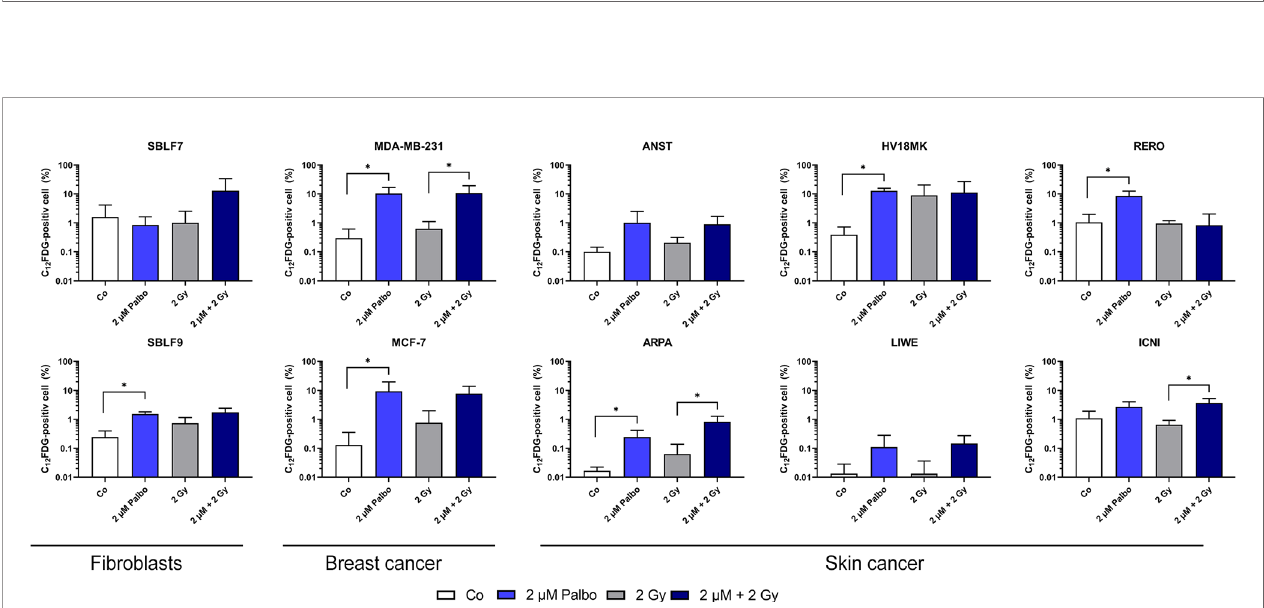
FIGURE 2 | Survival fractions of healthy fi broblasts and breast cancer and skin cancer cells. Clonogenicity of two healthy fi broblasts and two breast cancer and six skin cancer cell lines. Cells were treated with 1 µM palbociclib w/o 2 Gy. Values were normalized to the irradiated control fraction (blue dashed line). Each value represents mean ± SD ( n = 3). Signi fi cance was determined by one-tailed Mann – Whitney U test * p ≤ 0.05.